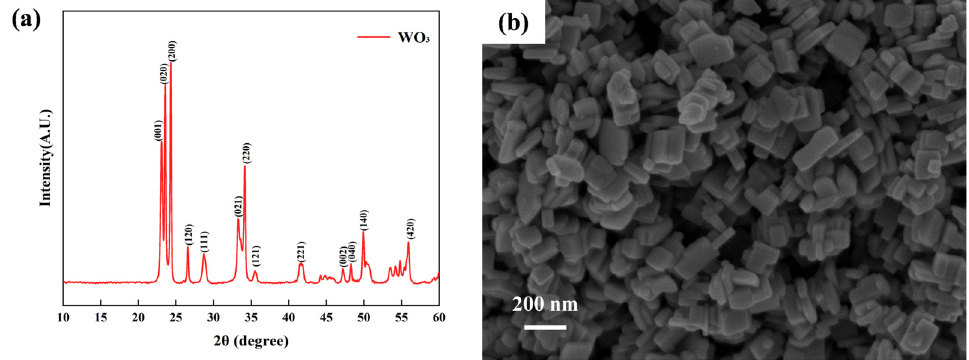
Figure 4. ( a ) XRD pattern, ( b ) FESEM image of the WO 3 nanoplates.